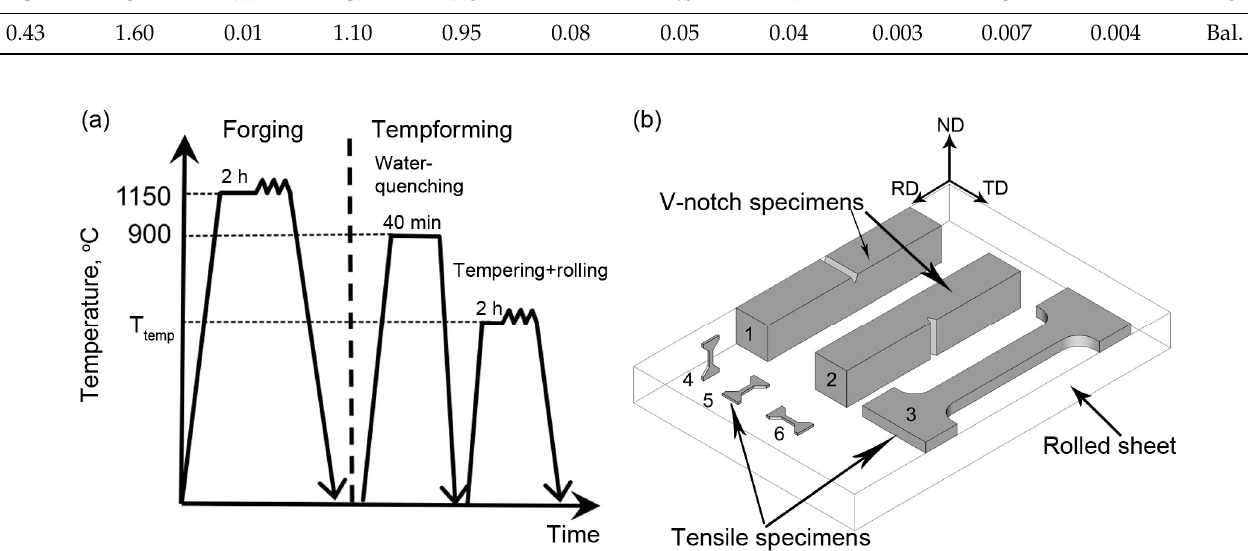
Figure 1. Schematic illustrations of the processing routes: ( a ) diagrams showing thermo-mechanical processing; and ( b ) the orientations for tensile and impact tests. 1—ND-Charpy V-Notch specimen, 2—TD-Charpy V-Notch specimen, 3—RD-standard-tension test specimen, 4—ND-mini-tensile test specimen, 5—RD-mini-tensile specimen, 6—TD-mini-tensile specimen.